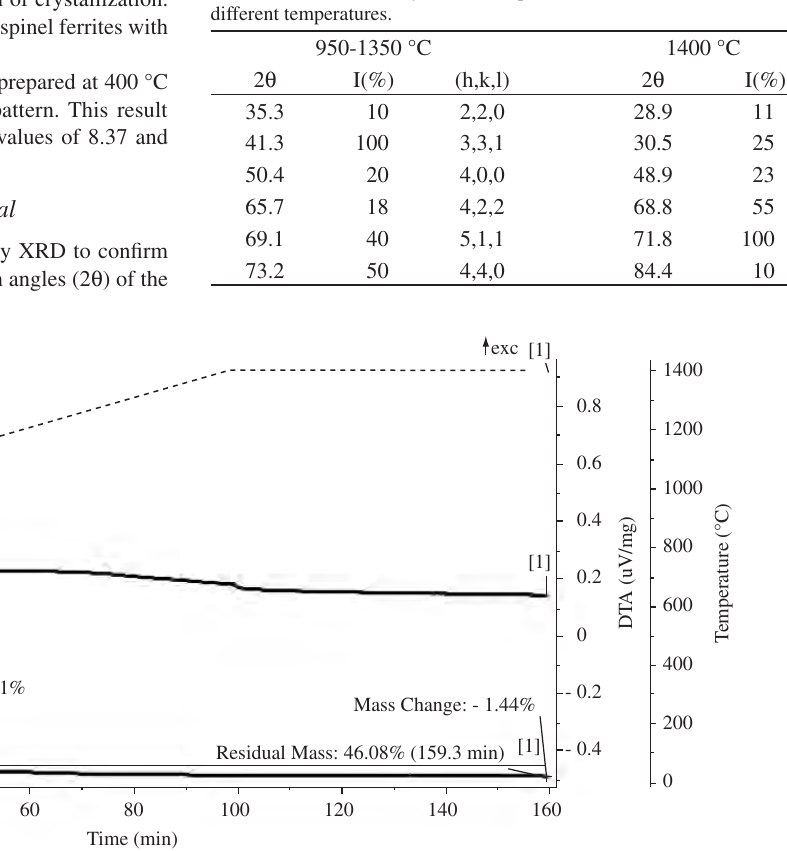
Figure 3a. Sintering at 1100 and 1200 °C (Figures 3b, 3c)